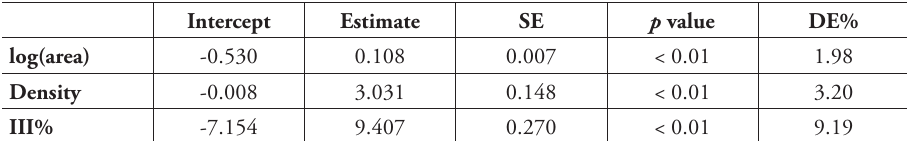
Table 3. Overall effect of the three predictors on the seed set, estimated by three single GLM analyses. log(area) = natural logarithm of the area occupied by each sub-population, III% = percentage of the class III stage-age individuals, SE = standard error, DE% = percentage of the deviance explained by each